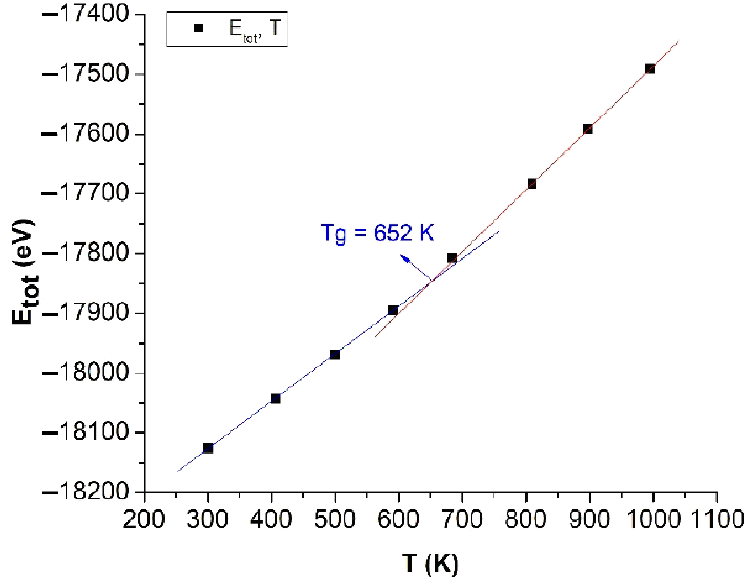
Figure 4. The relationship between the total energy of the system and the temperature of bulk Cu 5324 . The obtained results show that with increases in the temperature T, E tot always in- creased in linearity and was proportionally linear with T from about T = 300 K to T = 600 K and from T = 700 K to T = 1000 K. Increasing T led to l negligibly increasing; E tot increasing; the number of structural units FCC, HCP, and BCC decreasing; and Amor increasing, which indicates that approximately T = 600 K to T = 700 K is the glass temperature of bulk Cu 5324 material. According to the graph results, the intersection point between the two temperature ranges is called the glass point or the glass temperature (T g ), with the value T g = 652 K (Figure 4); the causes of this phenomenon are the size effect and the surface effect, and the phase transition of bulk Cu 5324 materials is a phase transition of type 1. To determine the crystallization process of bulk Cu 5324 material at the glass transition temperature T g = 652 K, we investigated the effect of annealing time; the content will be presented in detail in the following